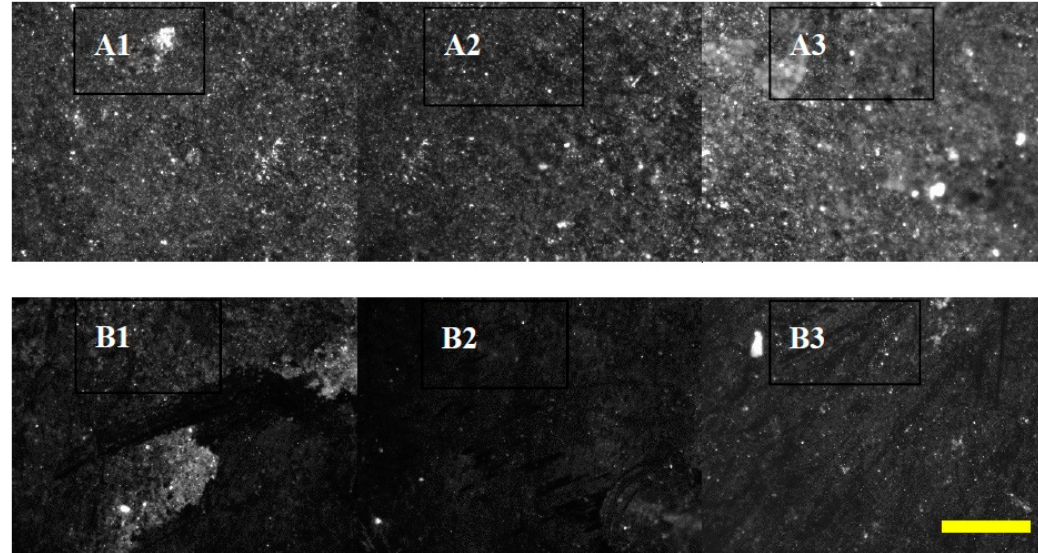
Figure 5. Biofilm formation on pyrite coupon surfaces in lignite column leaching experiments is enhanced after treatment with CPMW. Epifluorescence images of DAPI-stained cells (white) on dark pyrite surfaces are shown. Coupons from experimental columns with ( A1 – A3 ) and without ( B1 – B3 ) CPMW addition were imaged 2 (1), 4 (2), and 10 weeks (3) after addition of 0.1% CPMW as a top layer on the columns. The size bar represents 100 µm. Experimental details are given in [23].